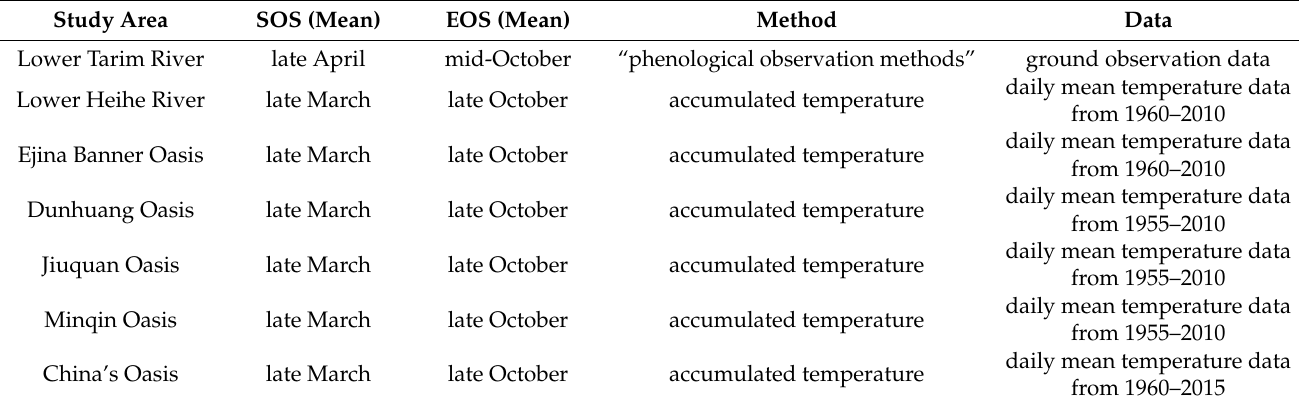
Table 3. Canonical redundancy comparative study on the phenology of P. euphratica [60–66]. Study Area